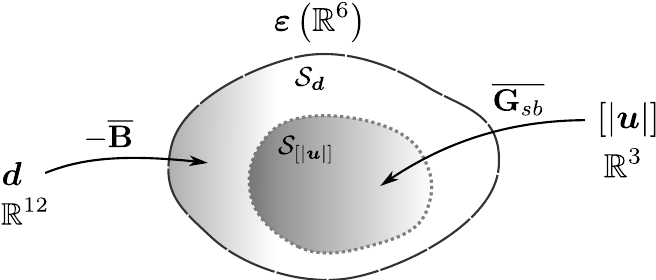
] . The subspace generated by the u | |